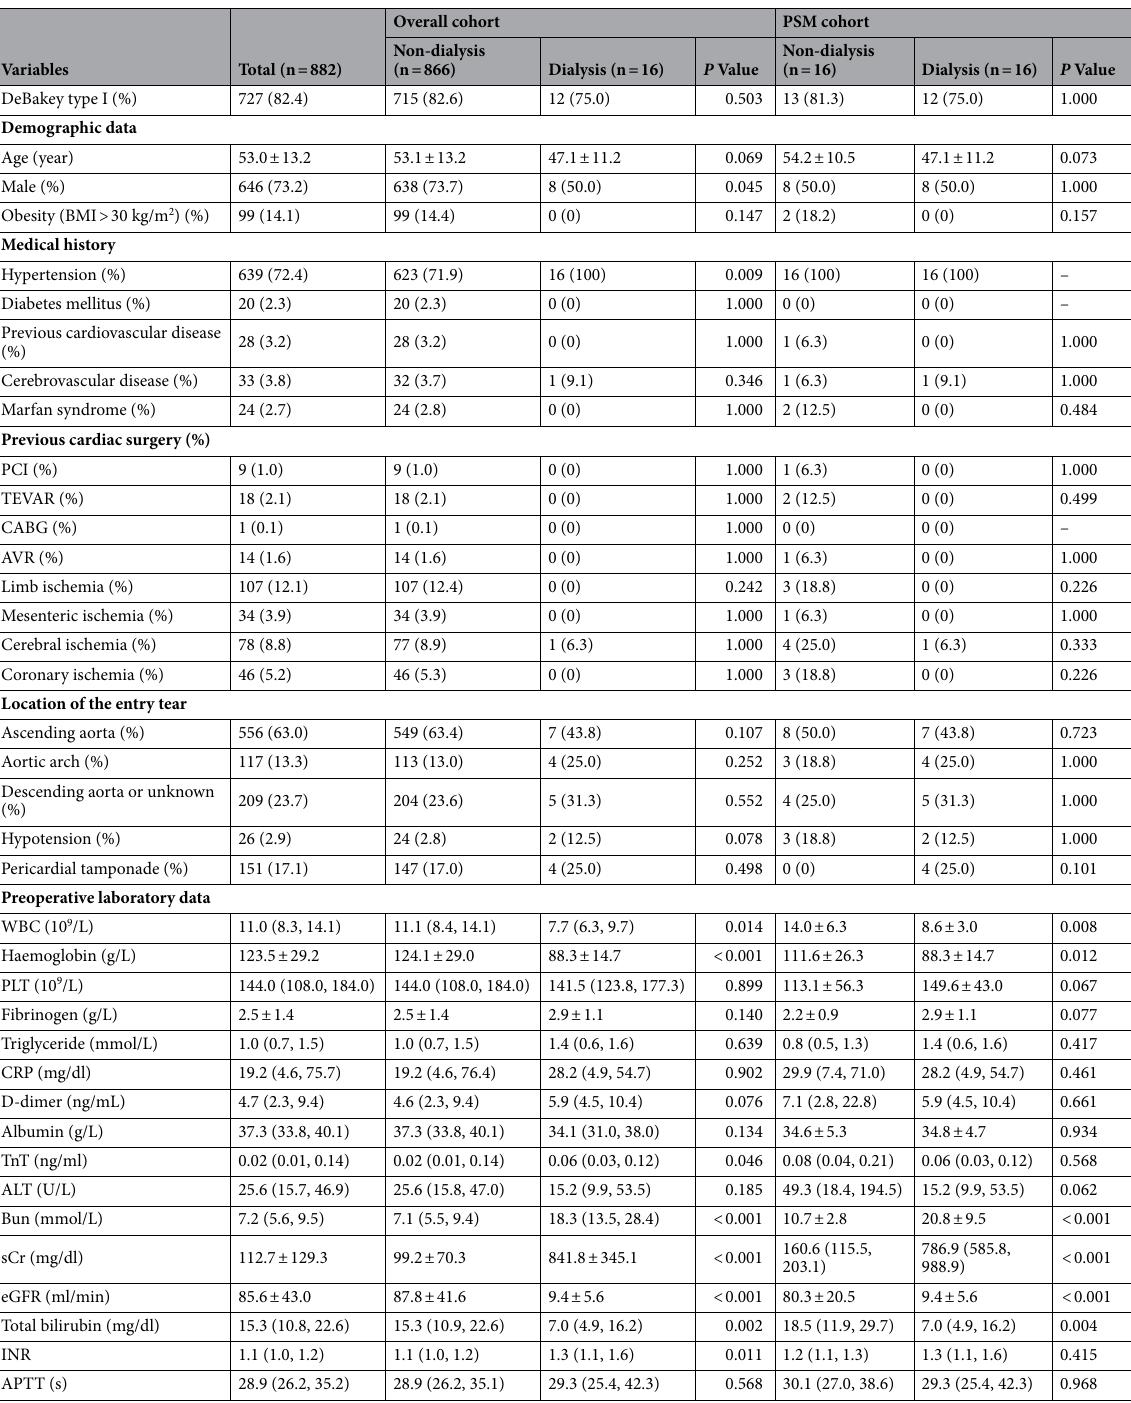
Table 1. Comparison of preoperative variables. Values for categorial variables are given as count (percentage); values for continuous variables are given as median (interquartile range) or mean ± standard deviation. BMI body mass index, WBC white blood cell, Bun blood urea nitrogen, sCr serum creatinine, PLT platelet, ALB albumin, CRP c-reactive protein, eGFR estimated glomerular filtration rate, INR international normalized ratio, PSM propensity score